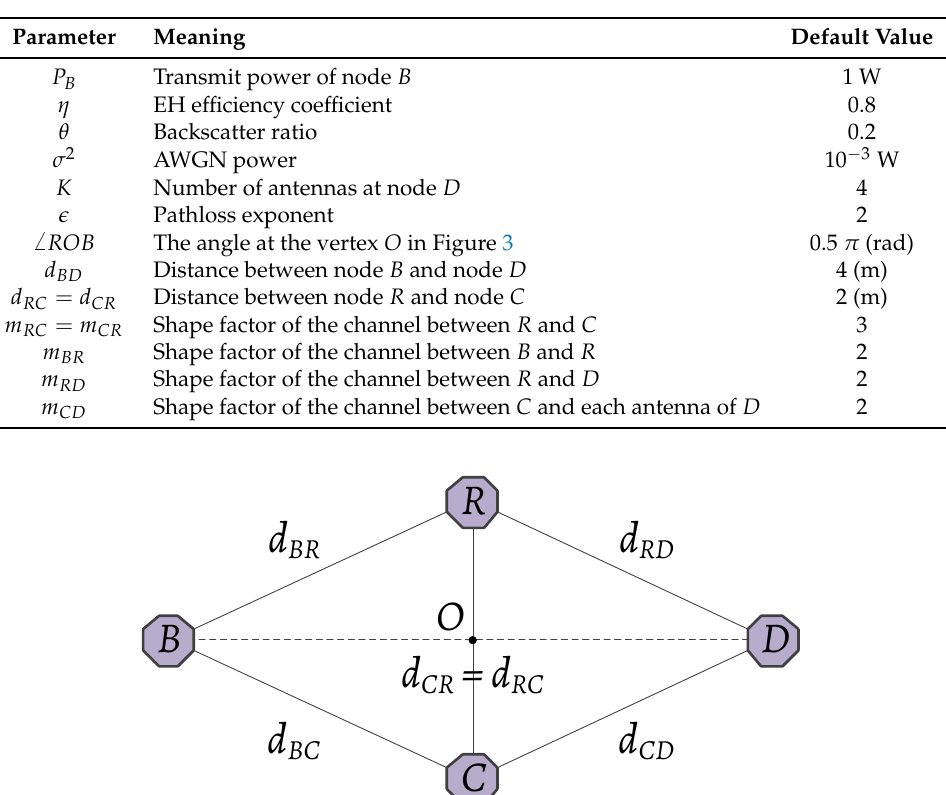
Table 2. Default parameters set for simulation.